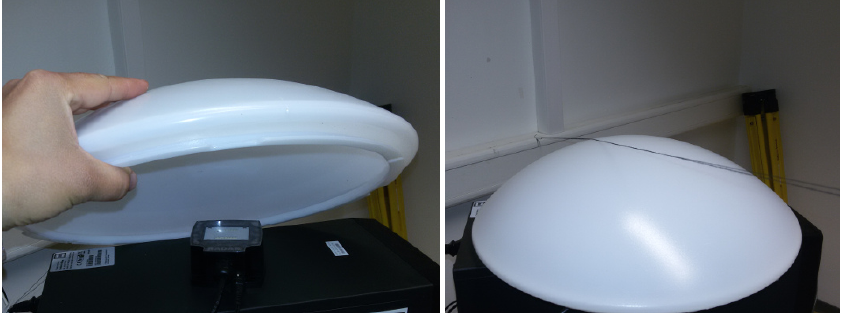
Figure A8. Light diffuser covering radar.